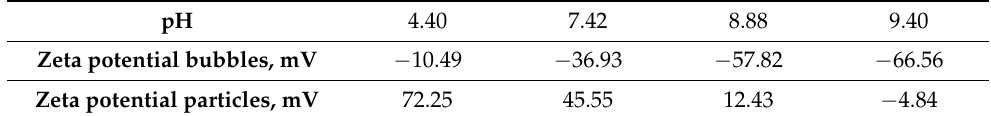
Table 1. Values of pH and the corresponding zeta potentials of the bubbles and the modified silica particles in suspension at 7.5 × 10 − 4 mol/L ionic strength.